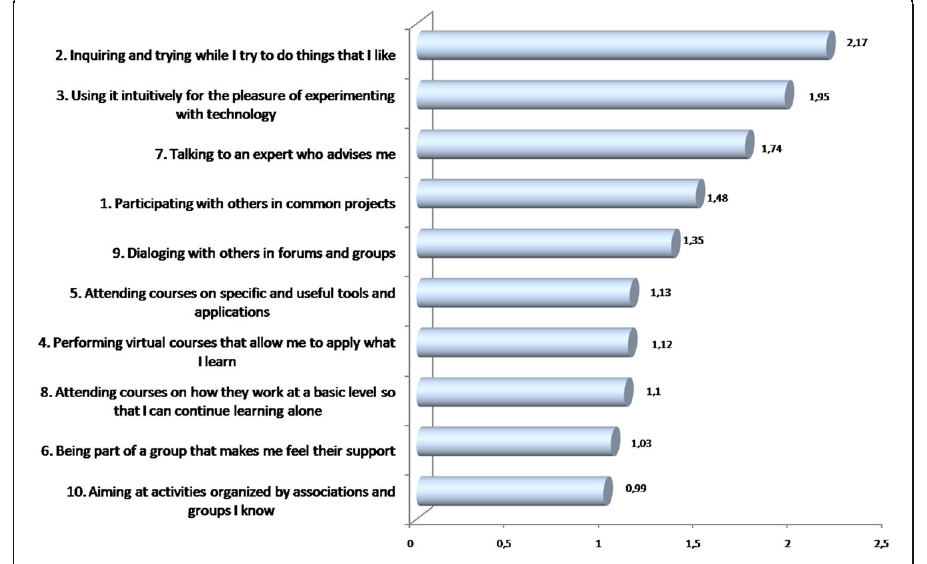
Fig. 1 ICT learning strategies used by female university